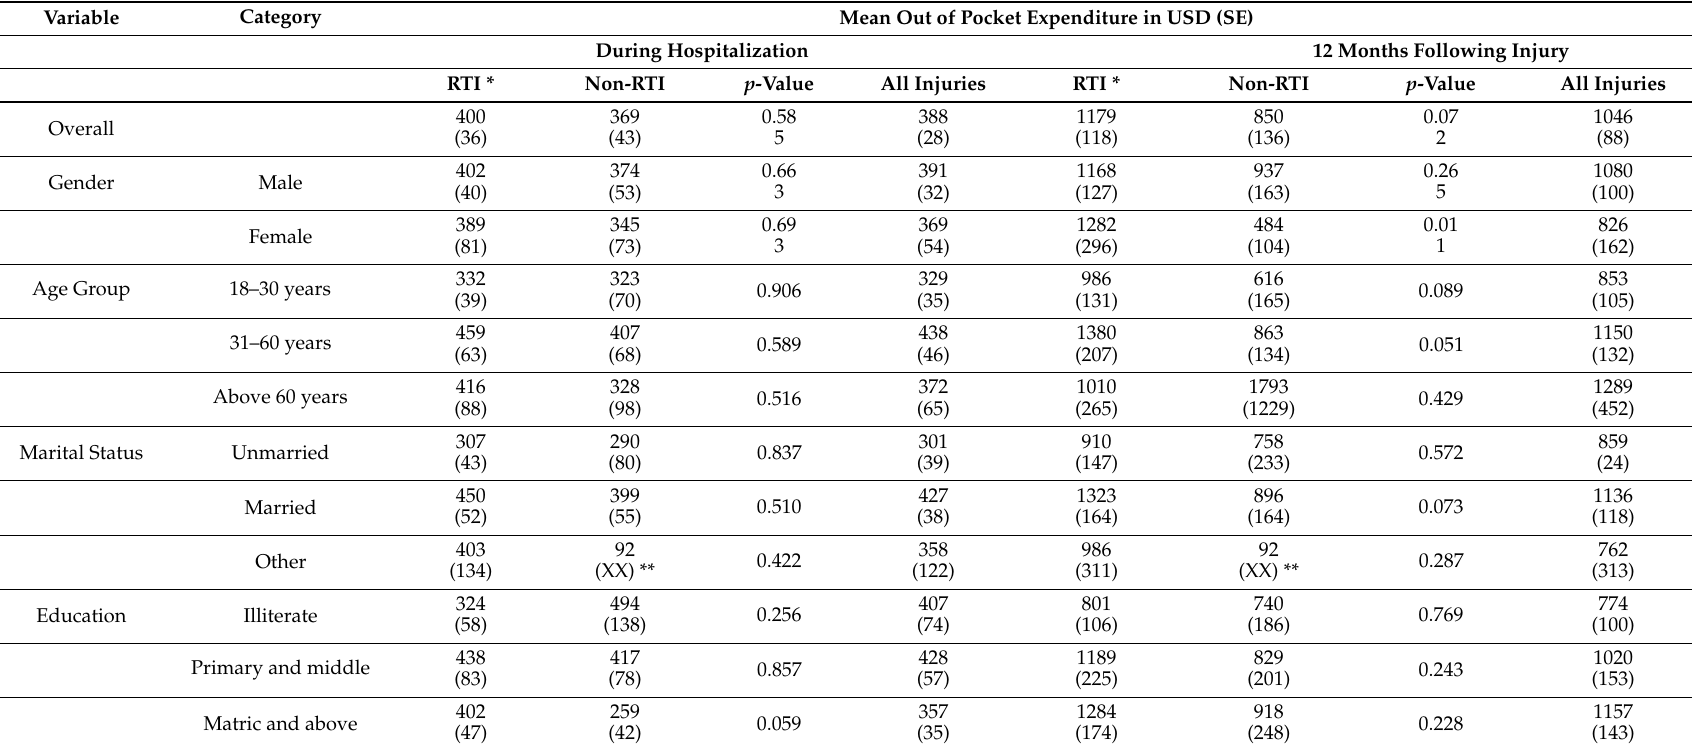
Table 2. Mean out of pocket (OOP) expenditure (USD) during hospitalisation and 12 months following